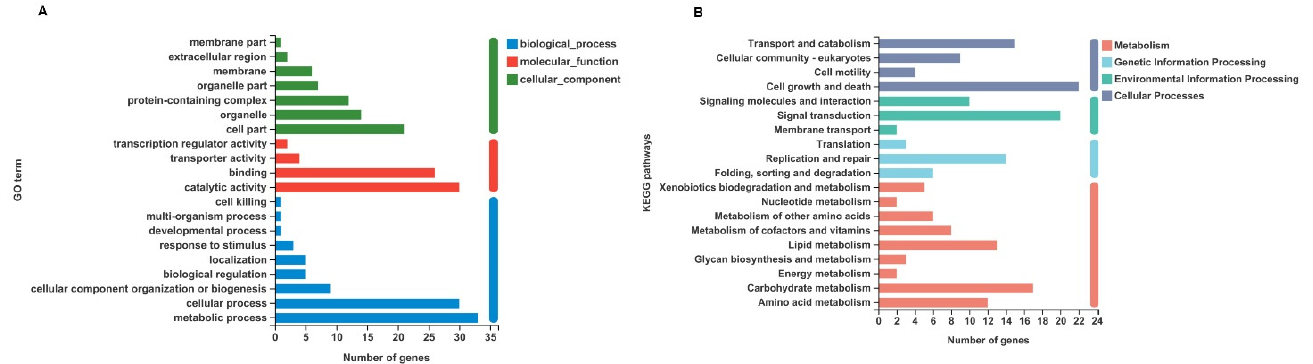
Figure 3. Functional classification analysis of the identified DEGs. ( A ) GO annotation analysis of the DEGs. The DEGs were classified into different GO terms according to biological process, molecular function, and cellular component. ( B ) KEGG pathway annotation analysis of the DEGs. The DEGs were categorized into various KEGG pathways according to metabolism, genetic information processing, environmental information processing, and cellular processes.